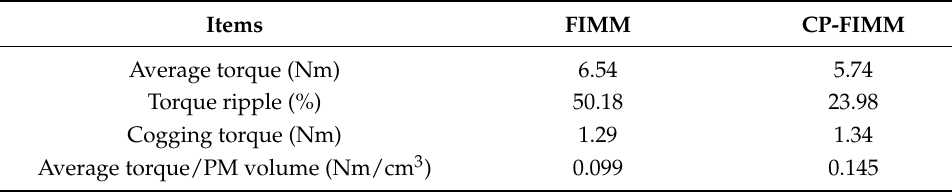
Table 3. Torque characteristics of the analyzed machines.